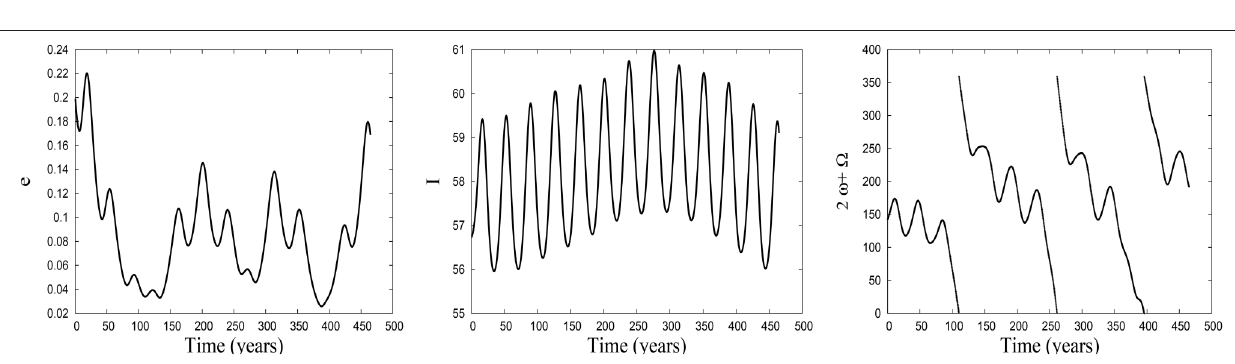
FIGURE 8 | Integration of the orbit having the initial conditions T = 0.04 , (cid:127) = 180 ◦ , σ = 142 ◦ and S = 0.41 (or e = 0.201 , I = 56.71 ◦